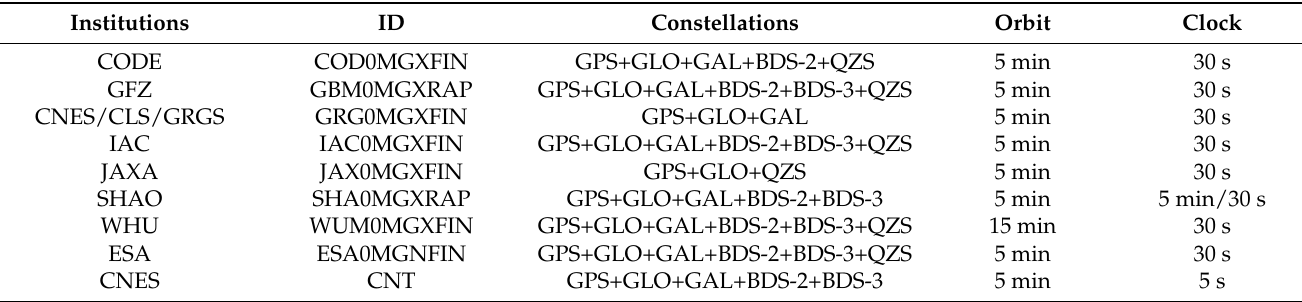
Table 1. Overview of the precise satellite orbit and clock products from multi-system analysis centers as of January 2021. Institutions